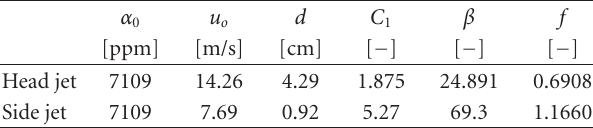
Figure 10: Boron jet lance. Table 13: Boron jet coe ffi